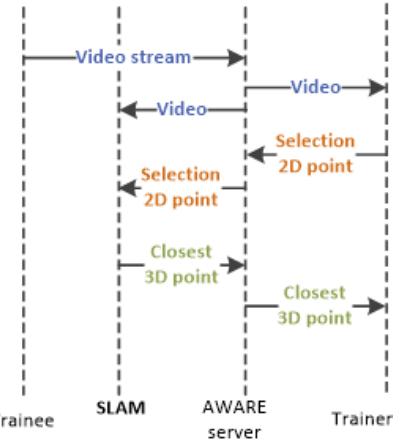
Figure 8. Diagram of data and event notification